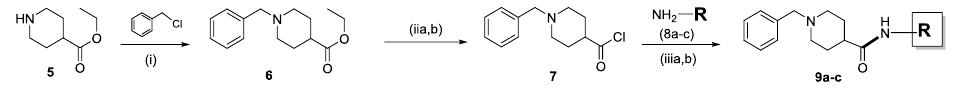
Figure 1. Structures of the synthesized hydrazones ( 4a – k ) and isonipecotates ( 9a – c ). Note that FW means Formula Weight and MP denotes Melting